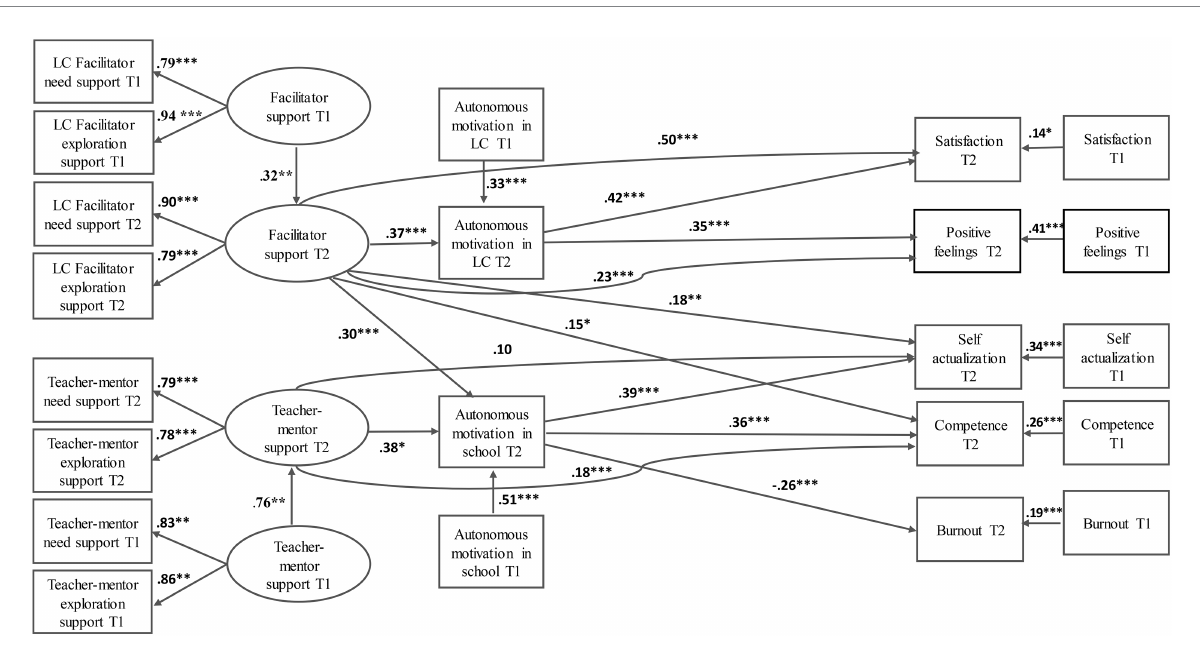
FIGURE 2 Structural equation modeling analysis results – T2. * p <0.05; ** p <0.01; *** p